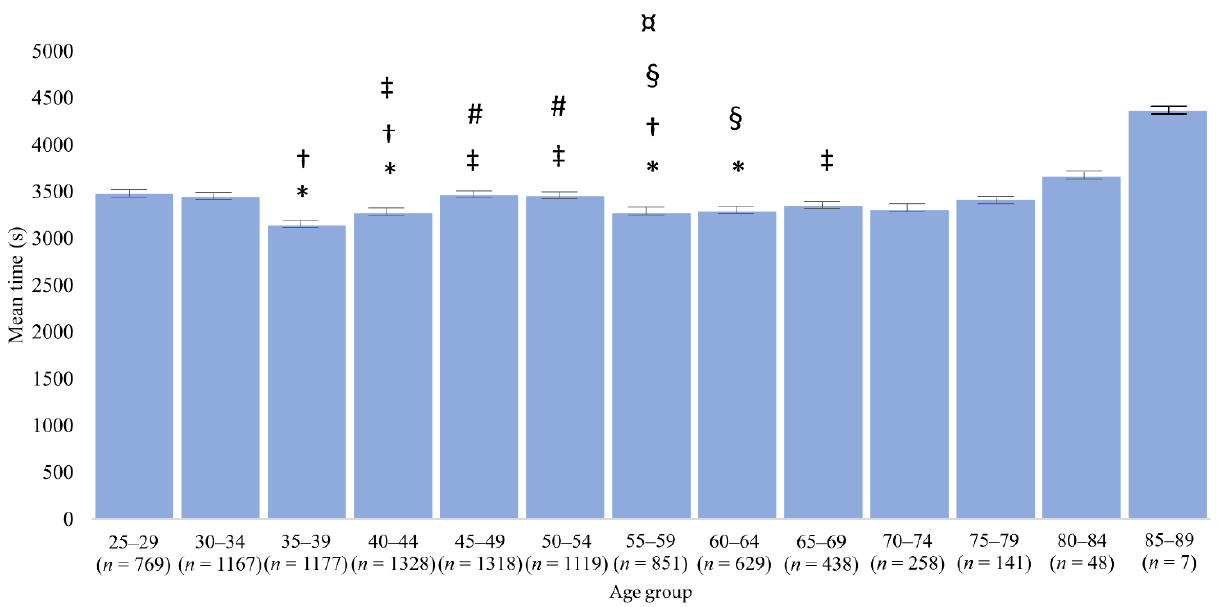
Figure 2. Mean times, confidence interval (95%) and difference between age groups in 3000 m open-water swimming WC between 1992 and 2019. * different from 25–29; † different from 30–34; ‡ different from 35–39; # different from 40–44; § different from 45–49; ¤ different from 50–54.